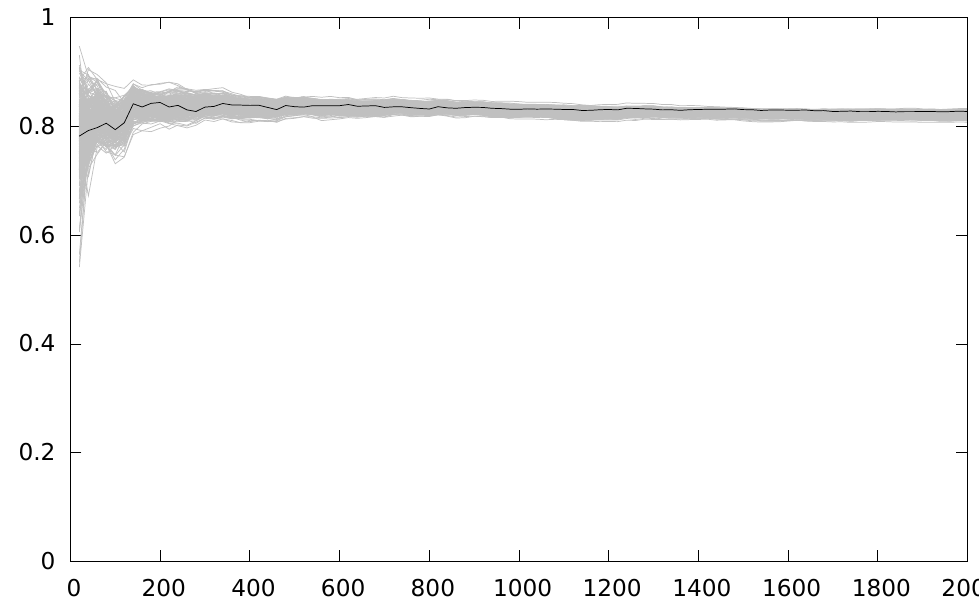
Figure 11. Maximum correlation for different key guesses vs . number of power traces when switching randomly between 3 implementations (2, 3 iterations and no unrolling) attacking with window of size 10.